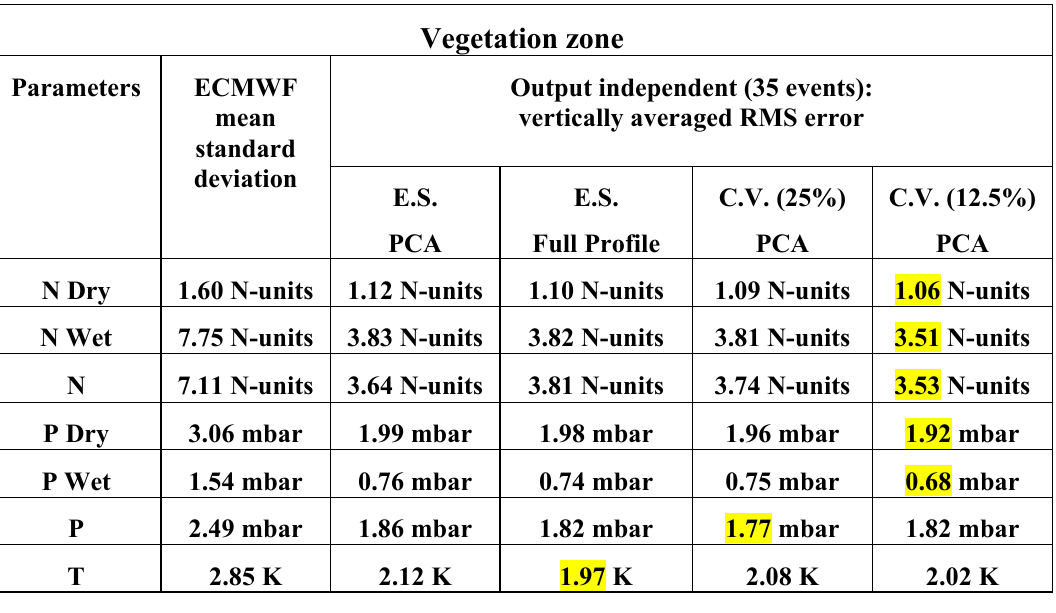
Table 6. Vegetation zone: comparison between mean standard deviation of ECMWF profiles, vertically averaged RMS error of dry refractivity (N Dry), wet refractivity (N Wet), refractivity (N), dry pressure (P Dry), wet pressure (P Wet), pressure (P) and temperature (T) profiles obtained by neural network independent test (35 events) using the different approaches. E.S.: Early Stopping; C.V.: Cross Validation. The best results are